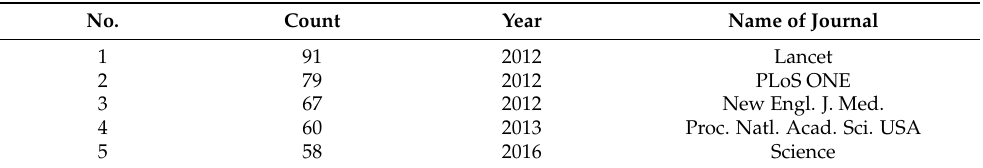
Table 6. Top 5 most productive journals publishing studies of epidemic control based on big data research, extracted through CS analysis.